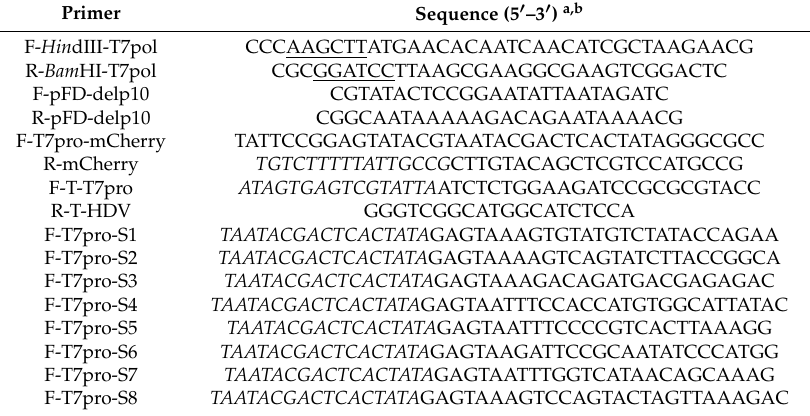
Table 1. Primers used in the